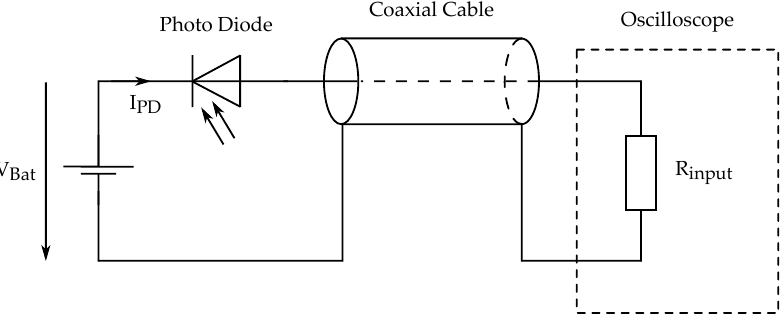
Figure 7. Schematic of the light